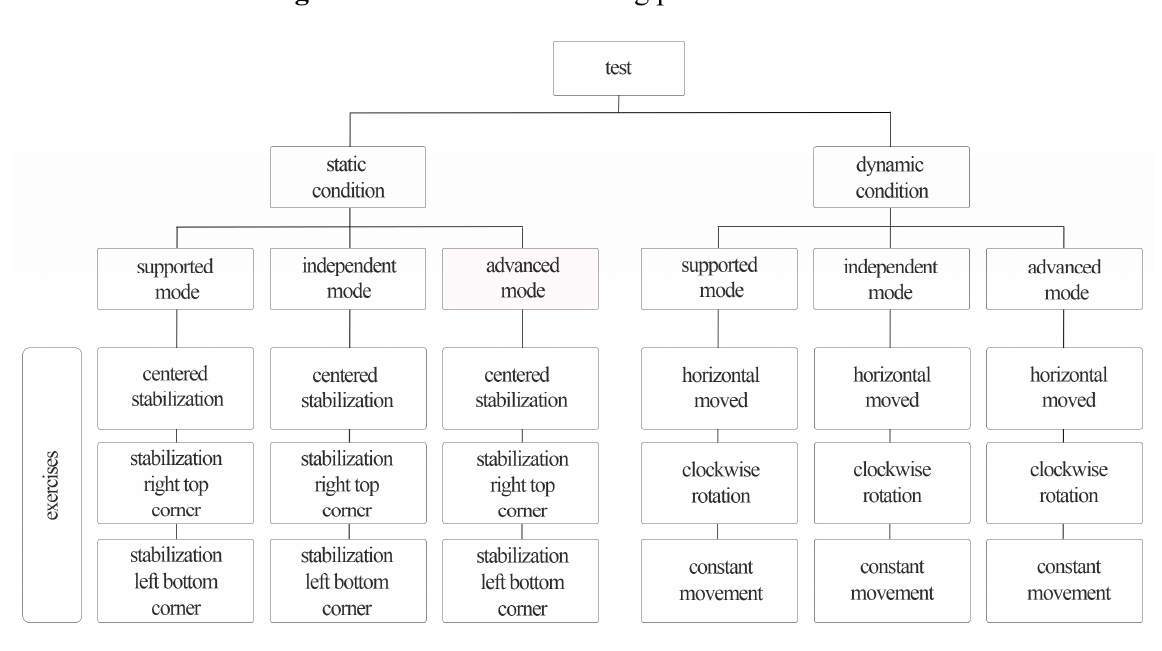
Figure 2. Schema of the testing process on the